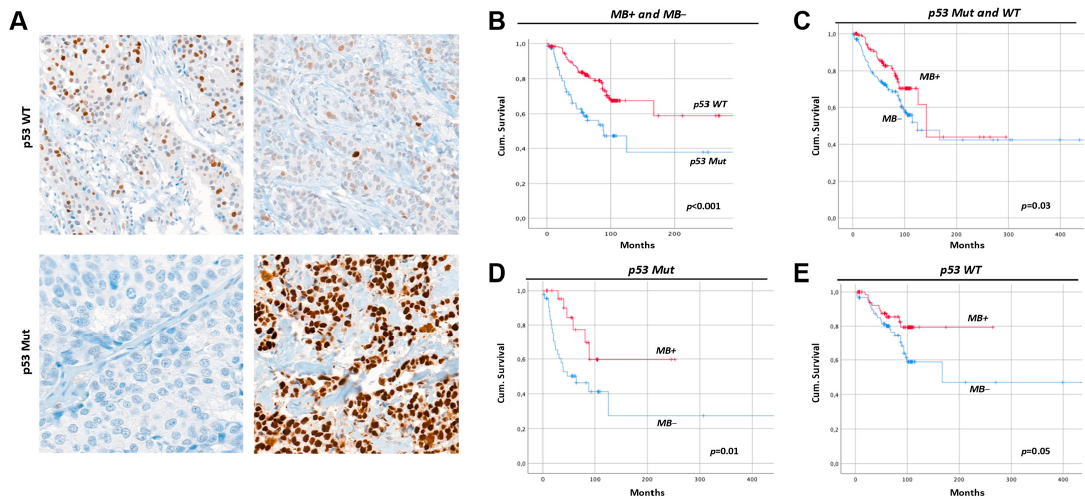
Figure 6. Myoglobin expression is linked to better prognosis independently of p53 status. ( A ) Rep- resentative image of immunohistochemistry staining of p53 in a cohort of human invasive ductal carcinoma ( n = 288). The upper left and upper right panels show moderate and weak expression of wildtype (WT) p53, respectively. The lower left and lower right panels show complete expression loss and pathological accumulation of p53, respectively, displaying the two forms of p53 mutation (p53 Mut) as detected by immunohistochemistry. Scale bar is 200 mm. ( B – E ) Kaplan–Meier analyses of a cohort of 288 primary breast cancer cases displaying ( B ) tumors with p53 WT expression and their significantly improved cumulative overall survival prognosis compared with tumor cases with p53 Mut. ( C ) tumors with high MB expression (MB+) show a significantly improved cumulative overall survival prognosis compared with cases of low Mb expression (MB − ) in mixed p53 back- ground status. ( D , E ) MB+ tumors show significantly improved cumulative overall survival progno- sis compared with MB − tumors, in p53 Mut as well as p53 WT cohorts, respectively.